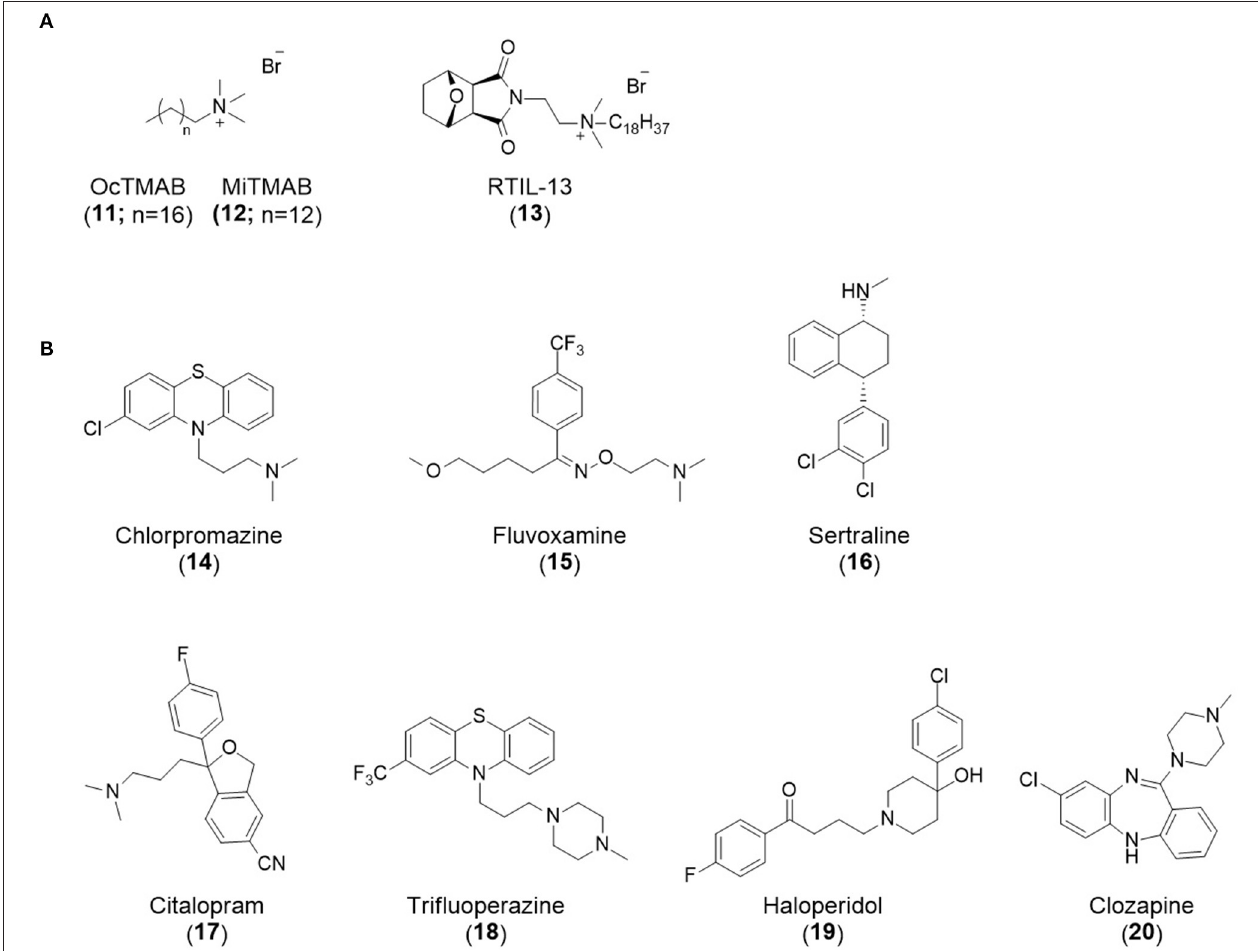
FIGURE 10 | Structures of, (A) long chain ammonium salt dynamin inhibitors OcTMAB ( 11 ), MiTMAB ( 12 ) and RTIL-13 ( 13 ); and (B) anti-psychotics and Selective Seretonin Reuptake as dynamin inhibitors; chlorpromazine ( 14 ), fluvoxamine ( 15 ), sertraline ( 16 ), citalopram ( 17 ), trifluoperazine ( 18 ), haloperidol ( 19 ), and clozapine ( 20